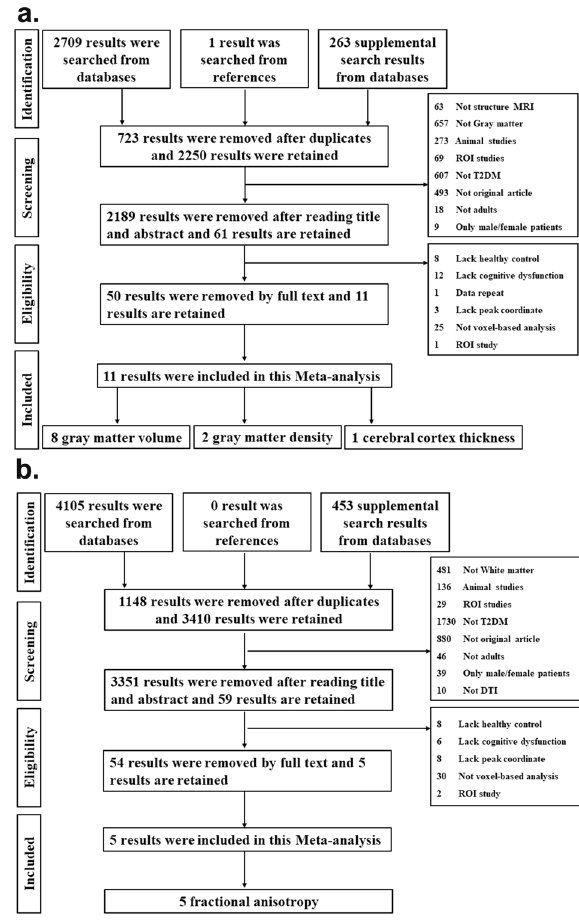
Fig. 1 Search fl ow diagram followed the PRISMA statement. The systemic searches were separately performed on GM ( a ) and WM studies ( b ).